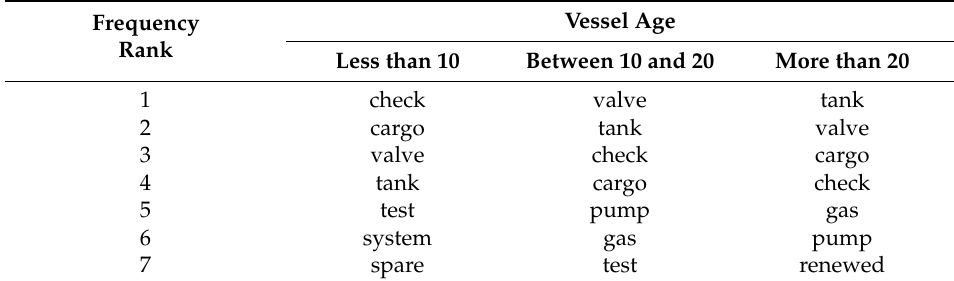
Table 2. Top-ranking maintenance items based on single-word